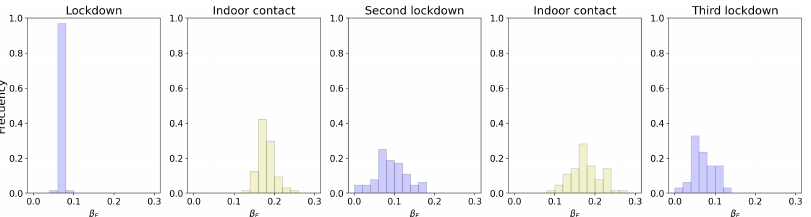
Figure 13. Histogram of 64 different counties of United Kingdom. The value of β E at the different levels of lockdown registered in 2020.